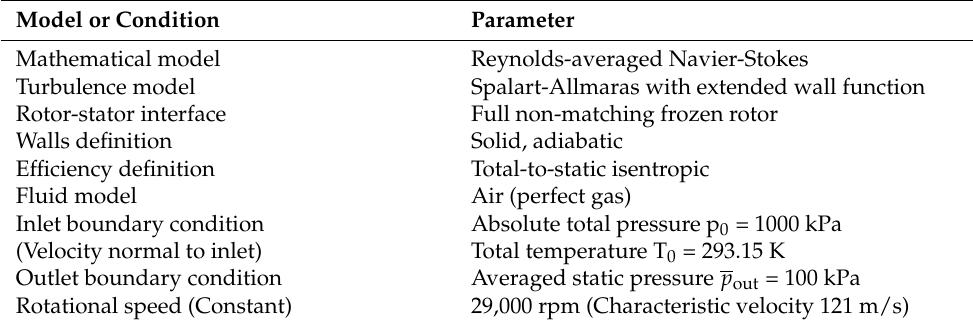
Table 2. Physical models and boundary conditions of the CFD